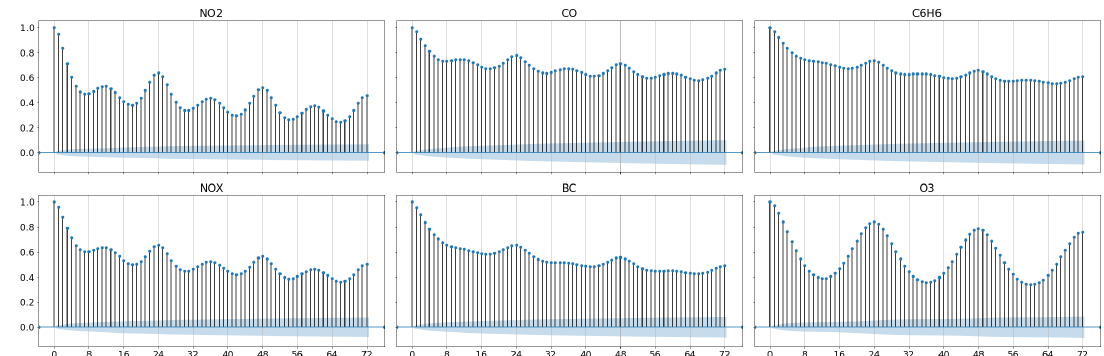
Figure 3. Correlation matrix between target variables and selected features.